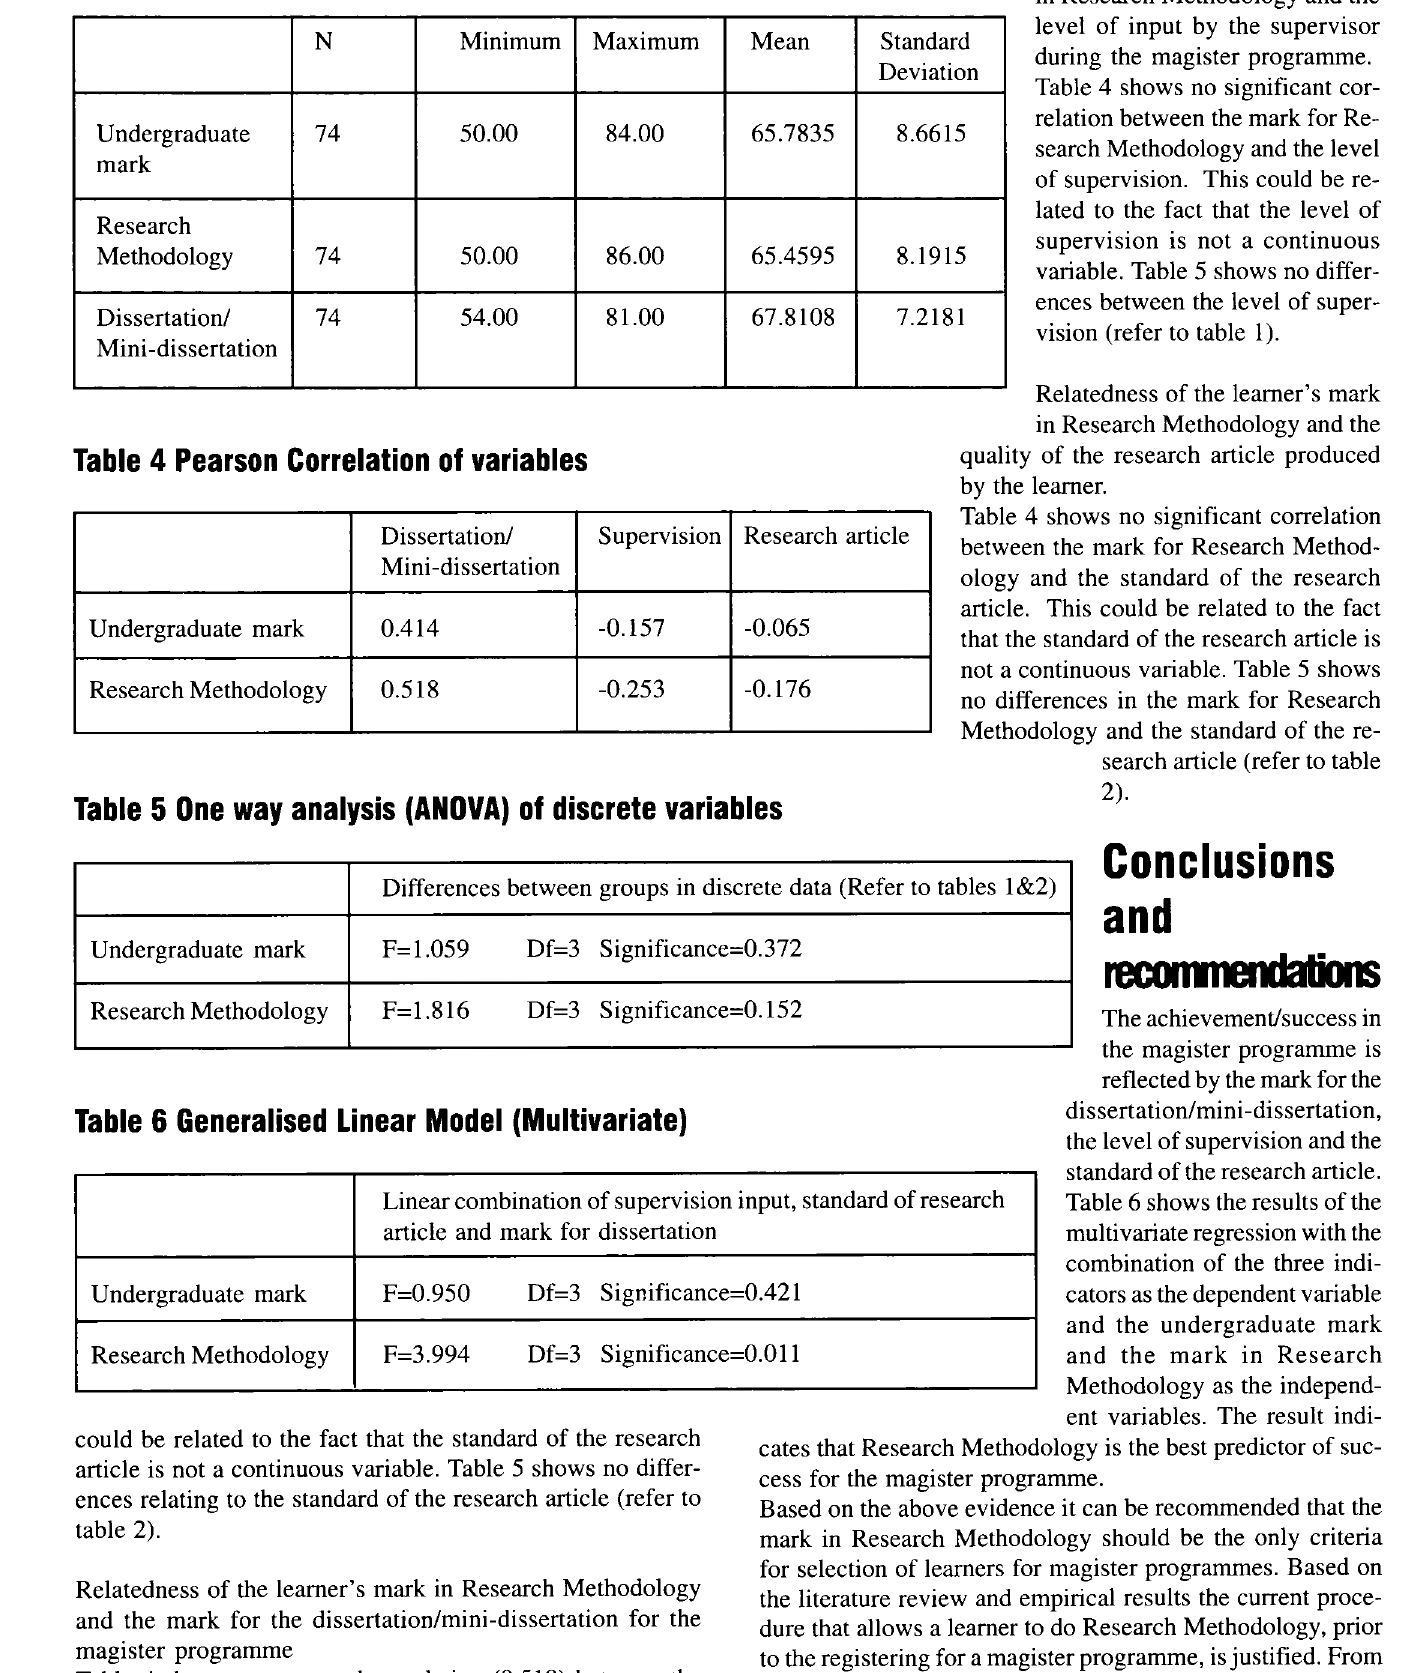
Table 3 Descriptive statistics of continuous variables